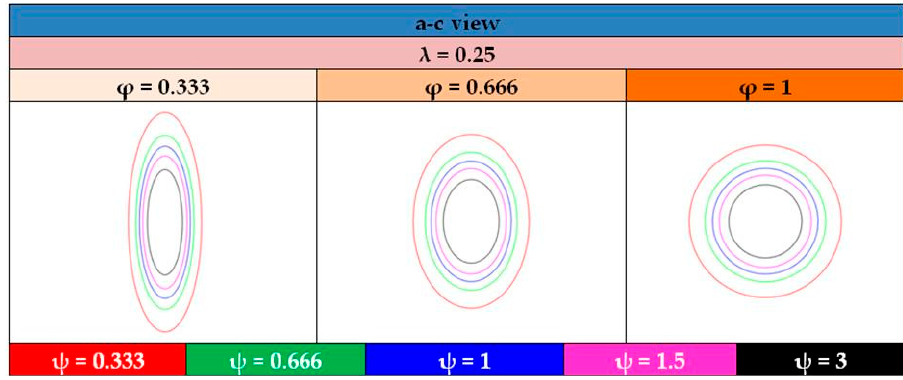
Figure 15. Graphical representation of the a–c view of tank configurations with λ = 0.25.